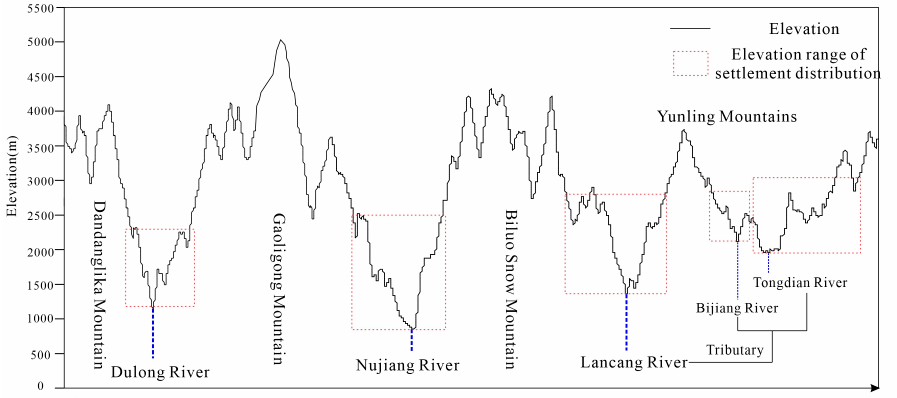
Figure 2. Map of Nujiang Prefecture “four mountains and three rivers”.